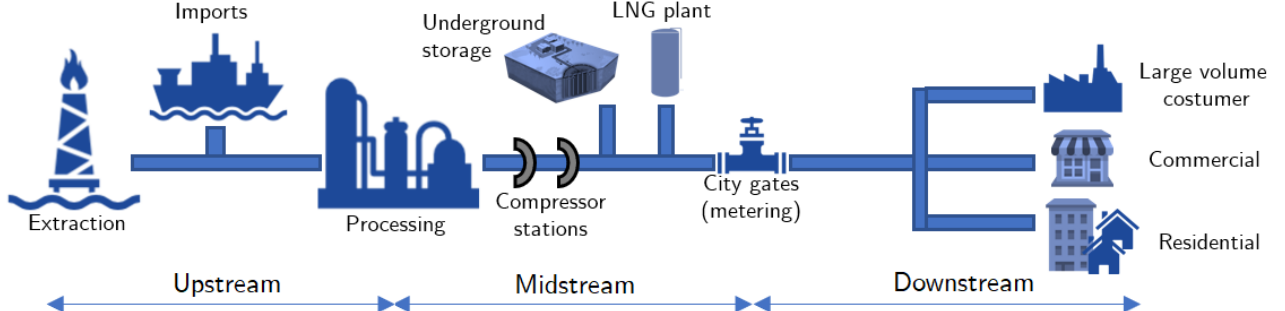
Figure 1. Schematic of the natural gas